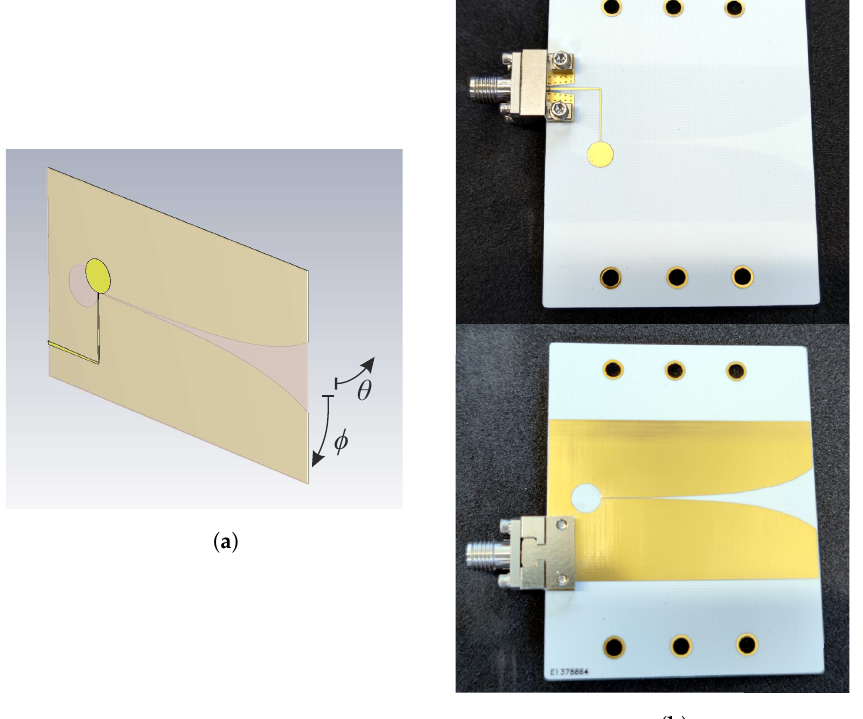
Figure 8. Simulation model ( a ) and manufactured Vivaldi Antenna ( b ) with end launch SMA